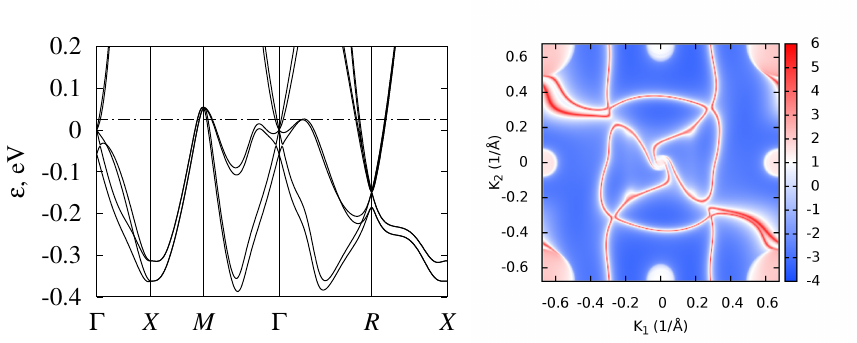
Figure 8. Band structure and surface Fermi arcs in